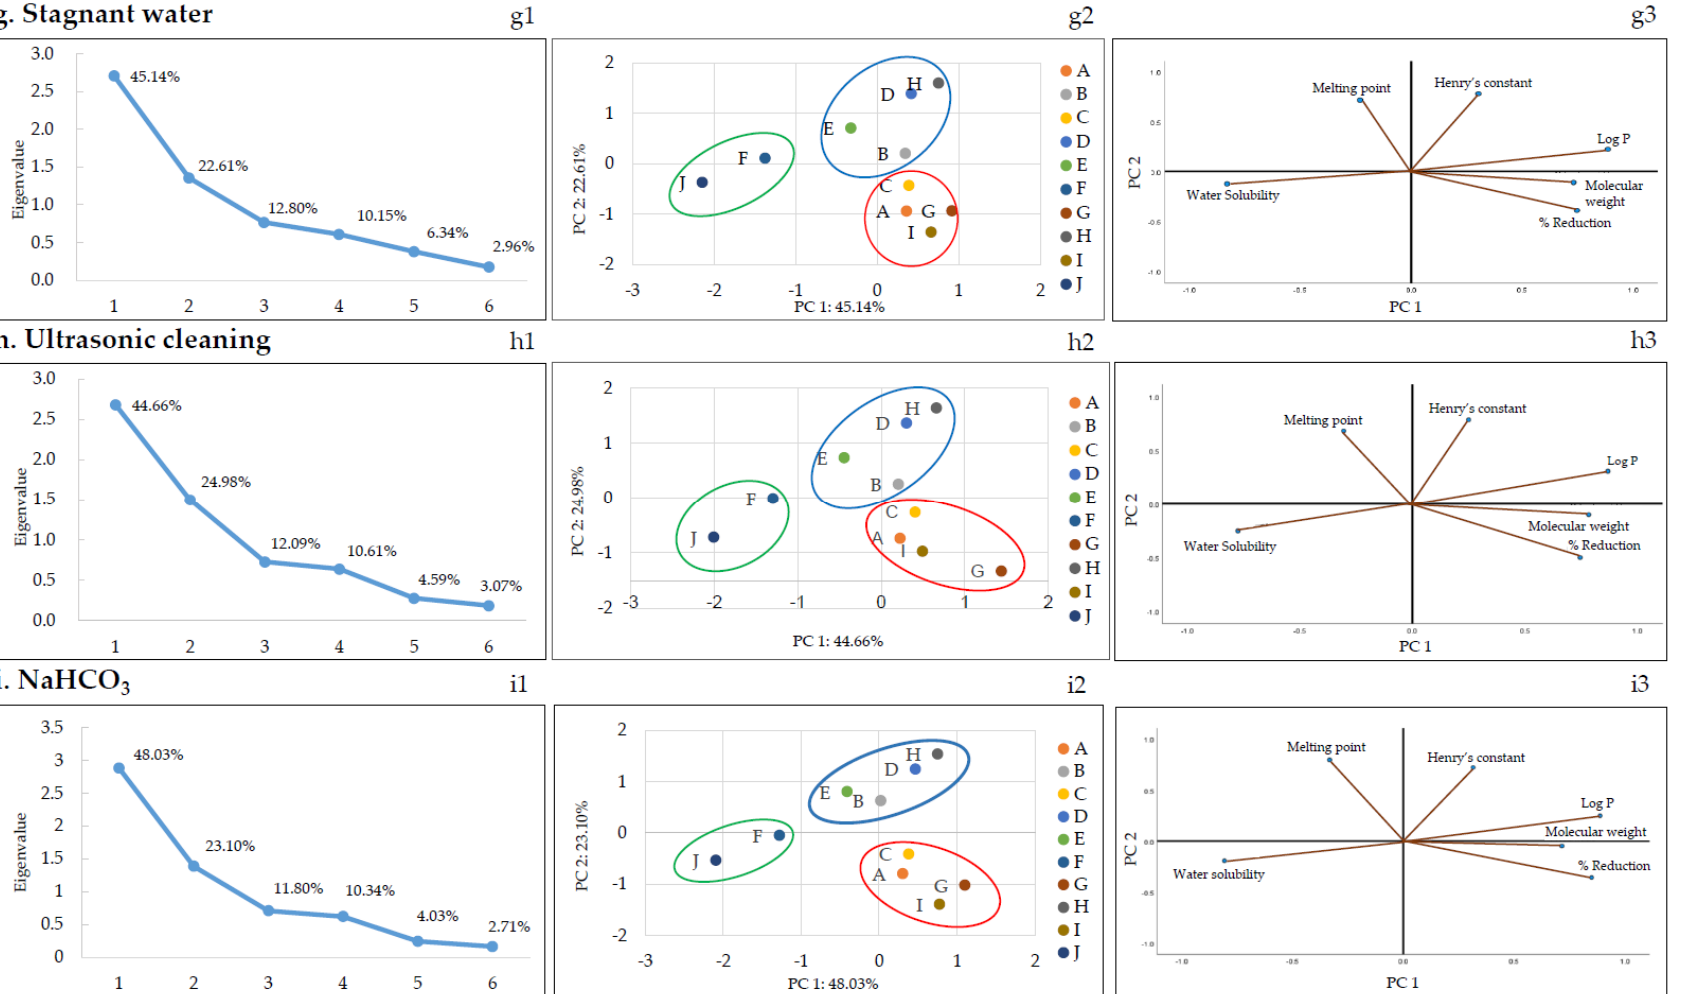
Figure 3. The plots of PCA: The scree ( a – i1 ), score ( a – i2 ), and loading ( a – i3 ) plots. A: Azoxystrobin, B: Chlorantraniliprole, C: Chlorfenapyr, D: Diniconazole, E: Fludioxonil, F: Imidacloprid, G: Indoxacarb, H: Lufenuron, I: Pyraclostrobin, and J: Thiamethoxam.